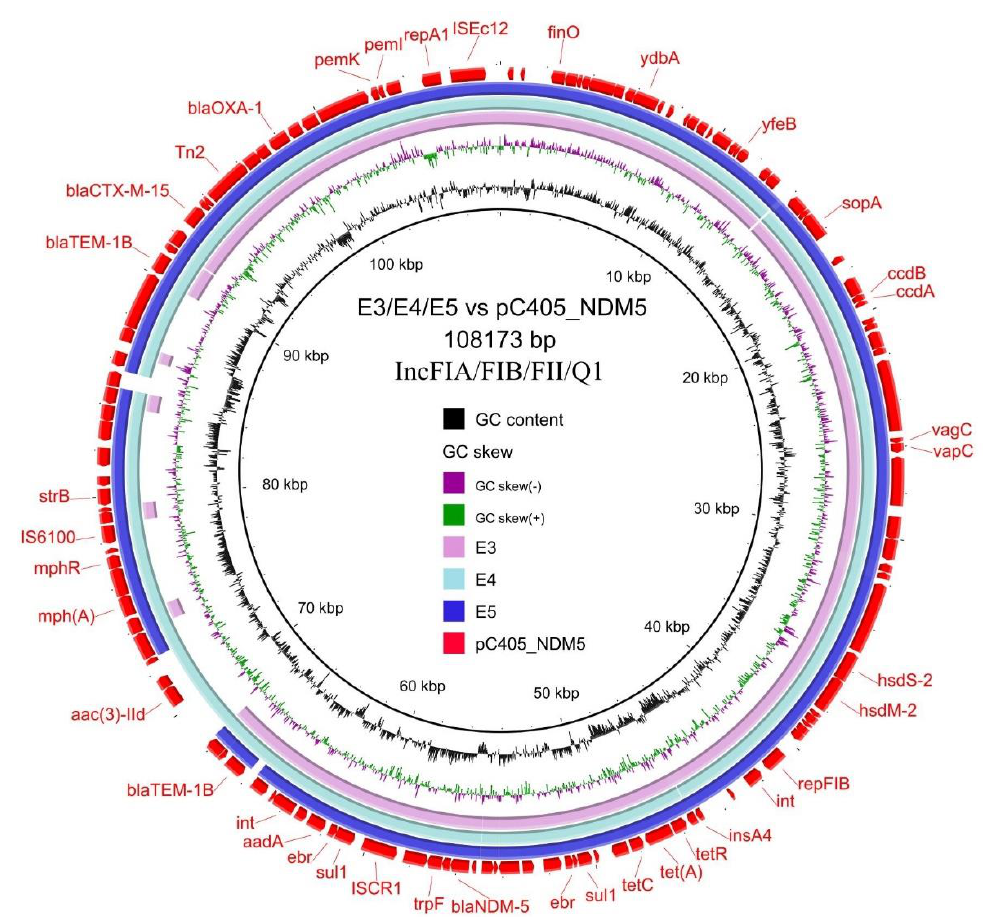
Figure 5. Circular alignments of the reference plasmid sequence (pC405 − NDM5, GenBank accession: LC521844) with homologous bla NDM-5 − carrying contigs from the E. coli strain E3, E4 and E5 in this study. Representative genes such as antimicrobial resistance genes, conjugation-associated genes and mobile genetic elements are labelled in the outermost circle.